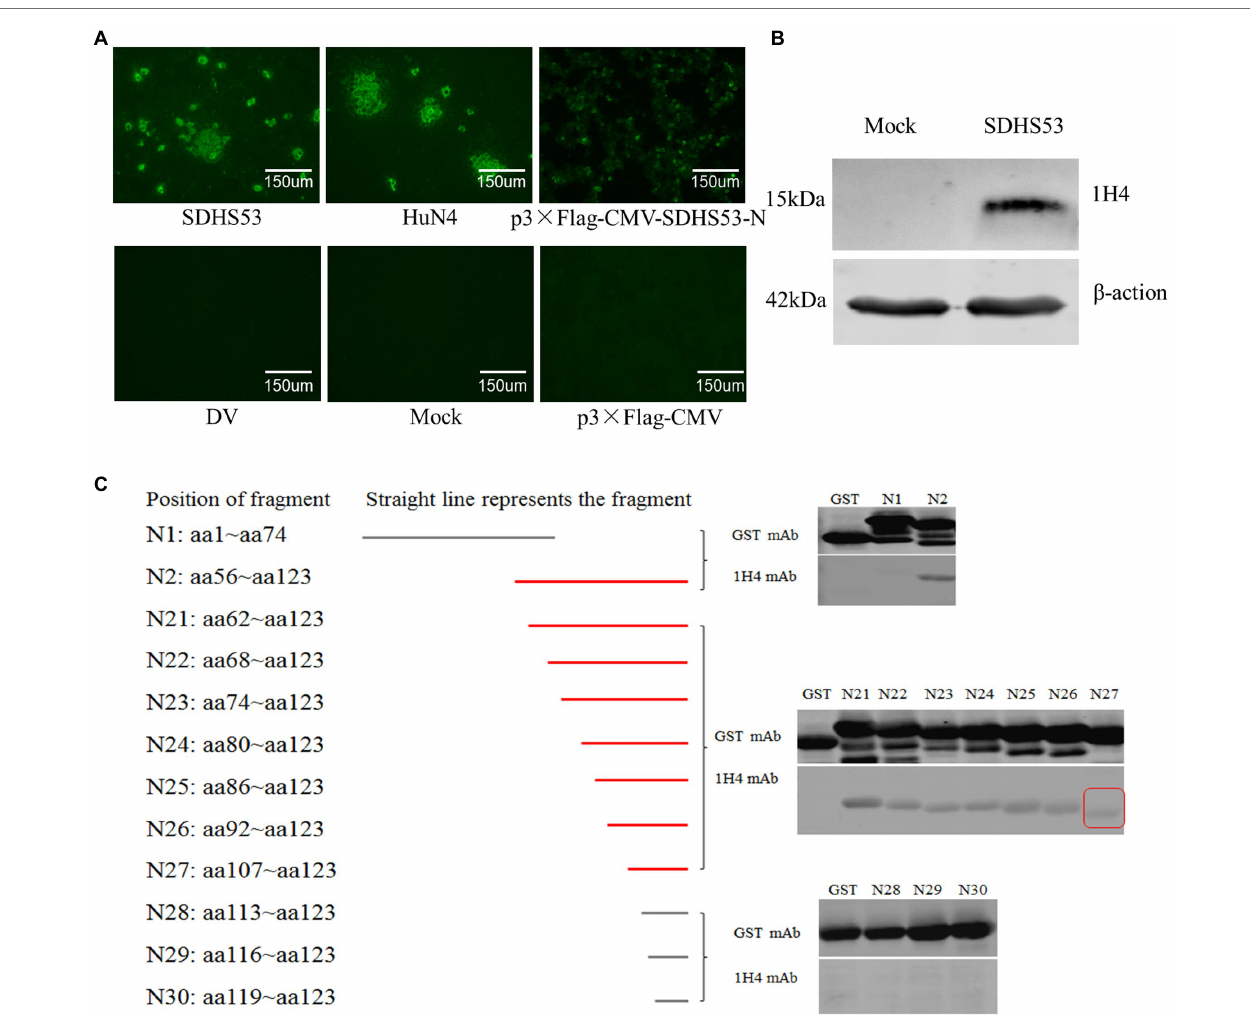
FIGURE 2 | Identification of mAb 1H4 that reacted with SDHS53 N protein. (A) Reactivity of mAb 1H4 with PRRSV and its N protein determined by IFA. mAb 1H4 reacted with NADC30-like PRRSV SDHS53 in Marc-145 cells and transiently transfected 293 T cells expressing the N protein. (B) Reactivity of mAb 1H4 with SDHS53 determined by Western blotting. (C) Identification of the epitope recognized by mAb 1H4 by Western blotting. All segments except N29 and N30 were amplified by PCR, whereas segments N29 and N30 were obtained by primer annealing. Peptide binding with mAb 1H4 is indicated by red lines. The smallest peptide binding with mAb 1H4 is indicated by a red